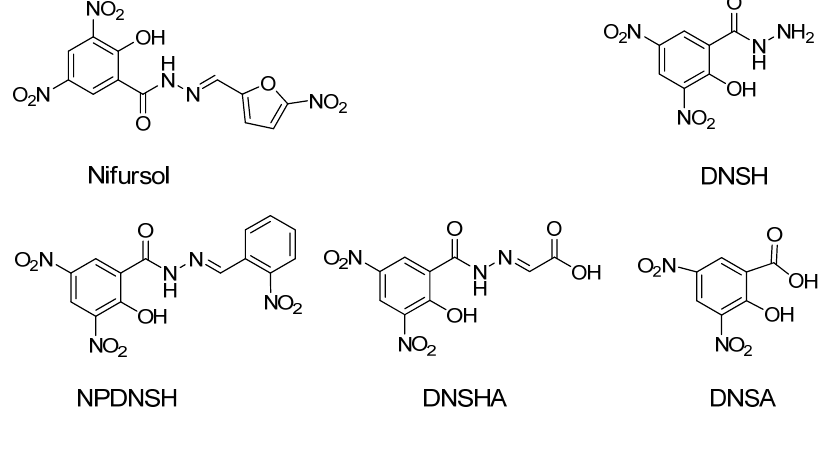
Figure 1. The structures of nifursol, DNSH, NPDNSH, DNSA and DNSHA